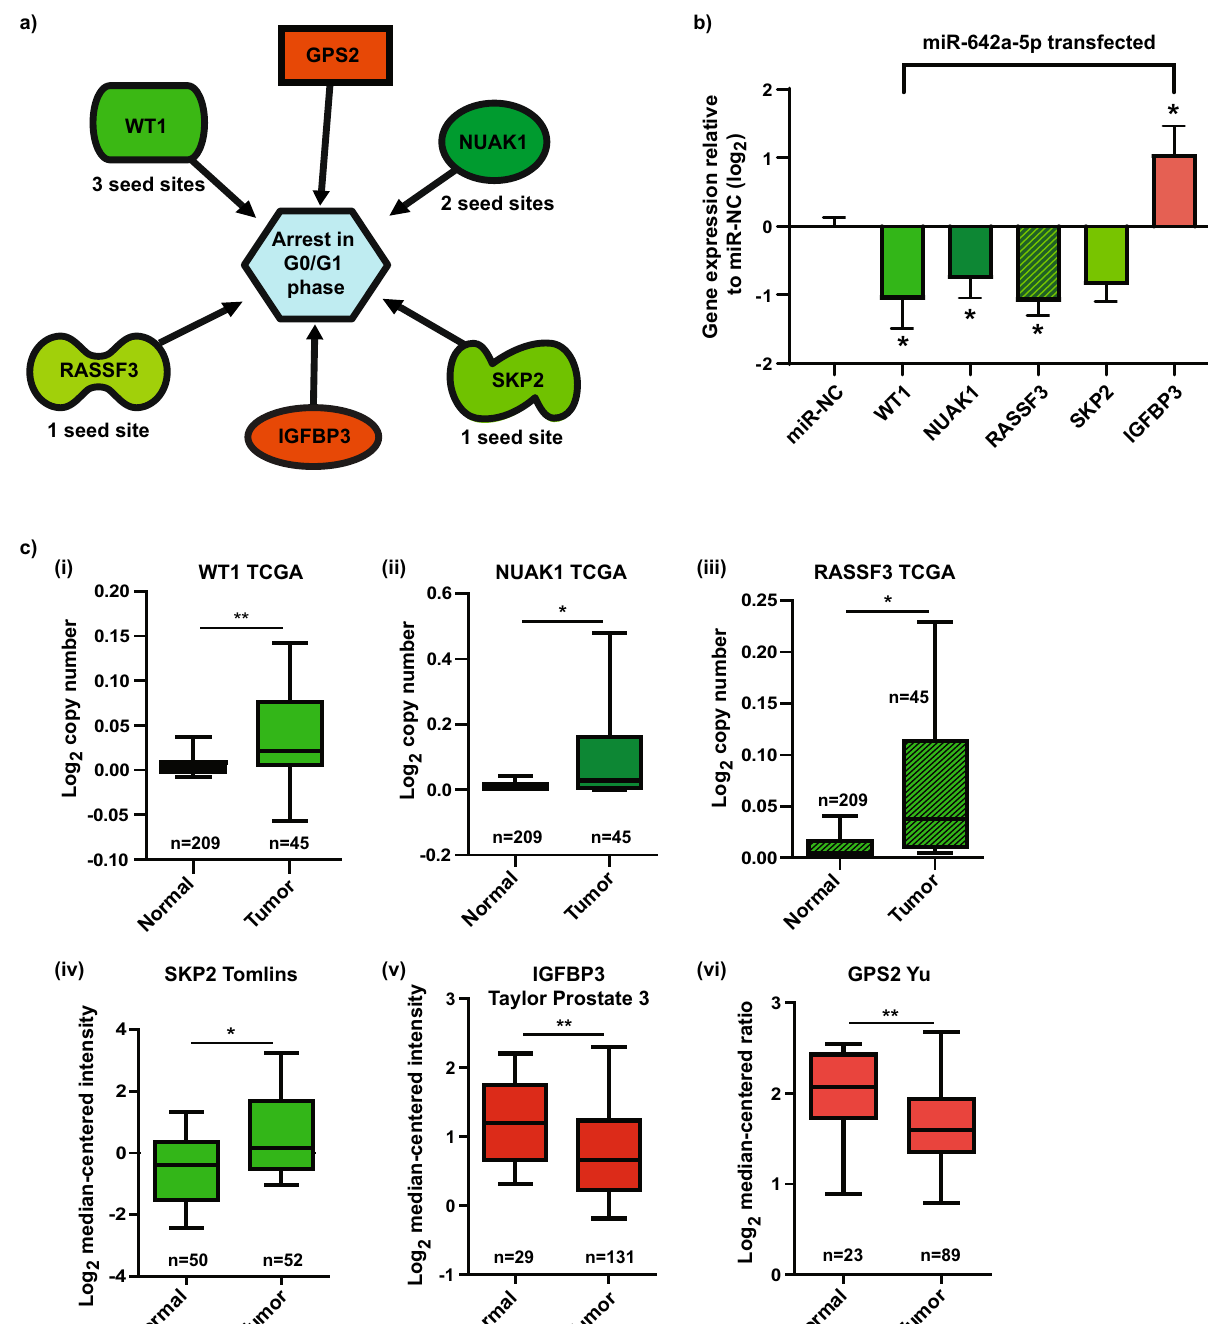
Figure 3. Cell cycle arrest gene targets of miR-642a-5p. ( a ) Ingenuity Pathway Analysis of cell cycle targets of miR-642a-5p. Green denotes genes downregulated by miR-642a-5p, and the number of seed sites in their 3’UTR (identified by TargetScan 7.2) indicated. Red denotes genes upregulated by miR-642a-5p. ( b ) RT-qPCR analysis of the cell cycle genes following overexpression of miR-642a-5p in 22Rv1 PCa cells. Expression of target mRNAs is normalized to HPRT housekeeping gene expression, calculated using the 2 −ΔΔCt method, and relative to miR-NC. Error bars = SE; n = 3; * p < 0.05 relative to miR-NC. ( c ) Oncomine analysis of the expression of the miR-642a-5p targets in PCa data sets. (i) WT1; (ii) NUAK1; (iii) RASSF3; (iv) SKP2; (v) IGFBP3; and (vi) GPS2. The data cohorts indicated above each graph, and n per group shown. Boxes denote the median (horizontal line); whiskers indicate distances to the highest and lowest values [for NUAK1 and RASSF3 the lower whisker is to the 10th percentile (minimum value removed)]. * p < 0.05, ** p <